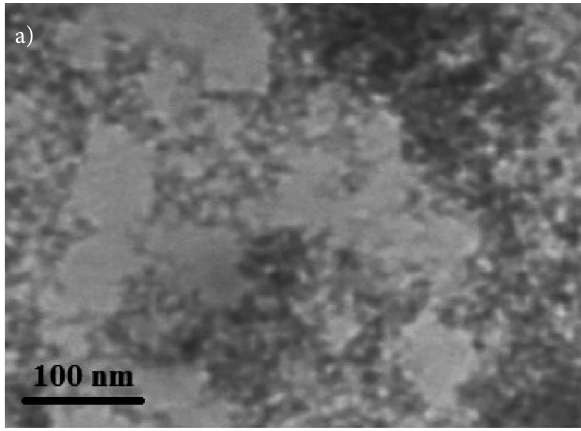
Figure 3. TEM (A) and SEM (B) images of the H-SAN